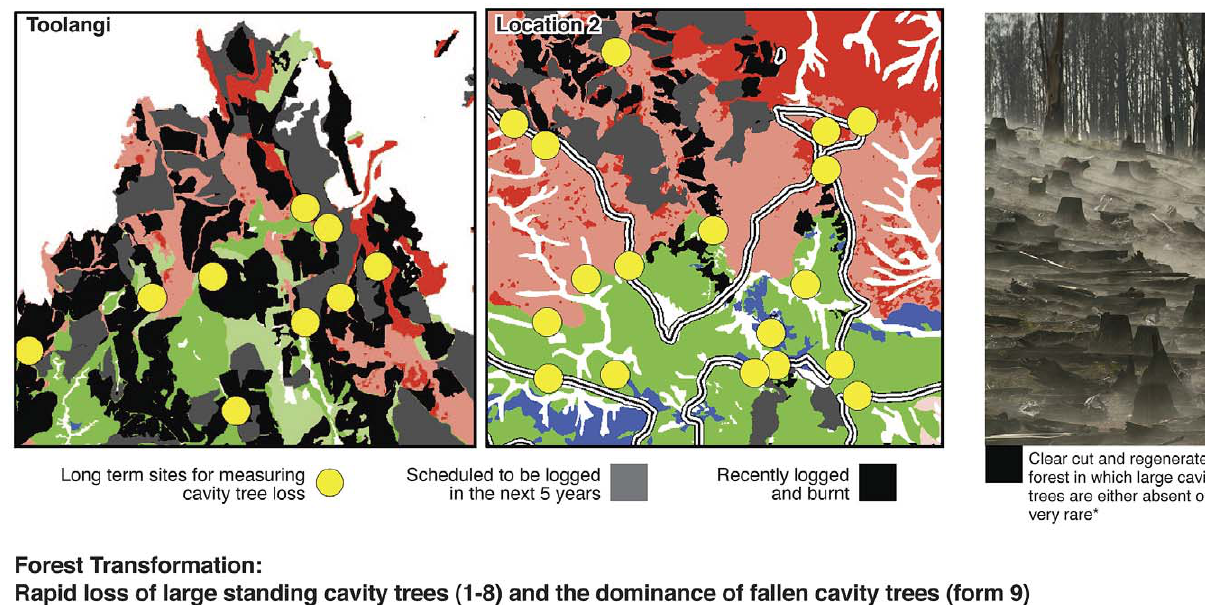
Figure 7. Projected abundance in 2039 and 2067 of large trees with cavities. The projection is for unlogged forest that was either unburned in 2009, subject to moderately severe fire in 2009 or subject to high severity fire in 2009. These projections are based on information contained in